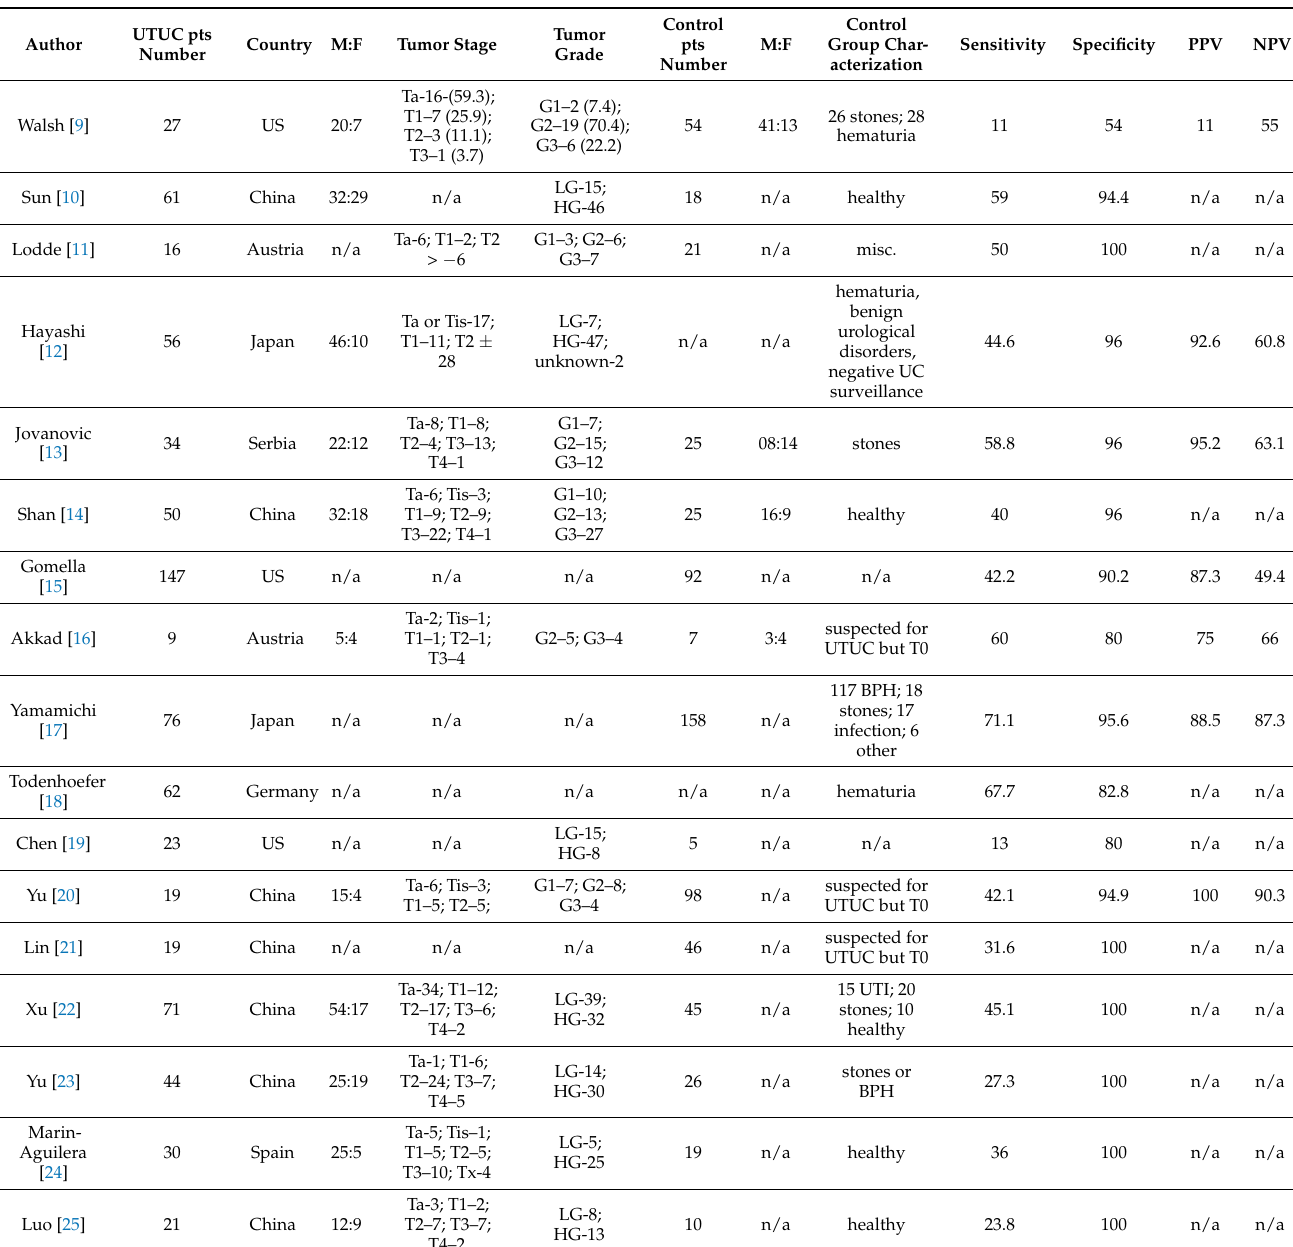
Table 1. The performance of VUC in the diagnosis of